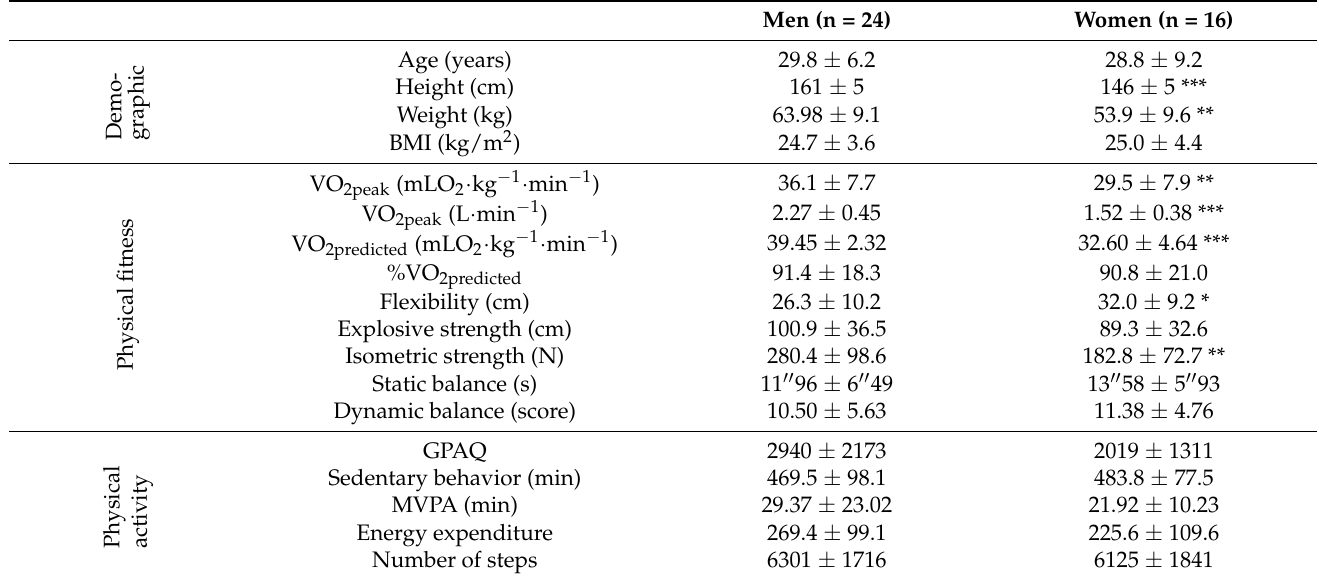
Table 1. Participants’ anthropometric characteristics, physical fitness and PA assessment related to gender. Men (n = 24) Women (n =